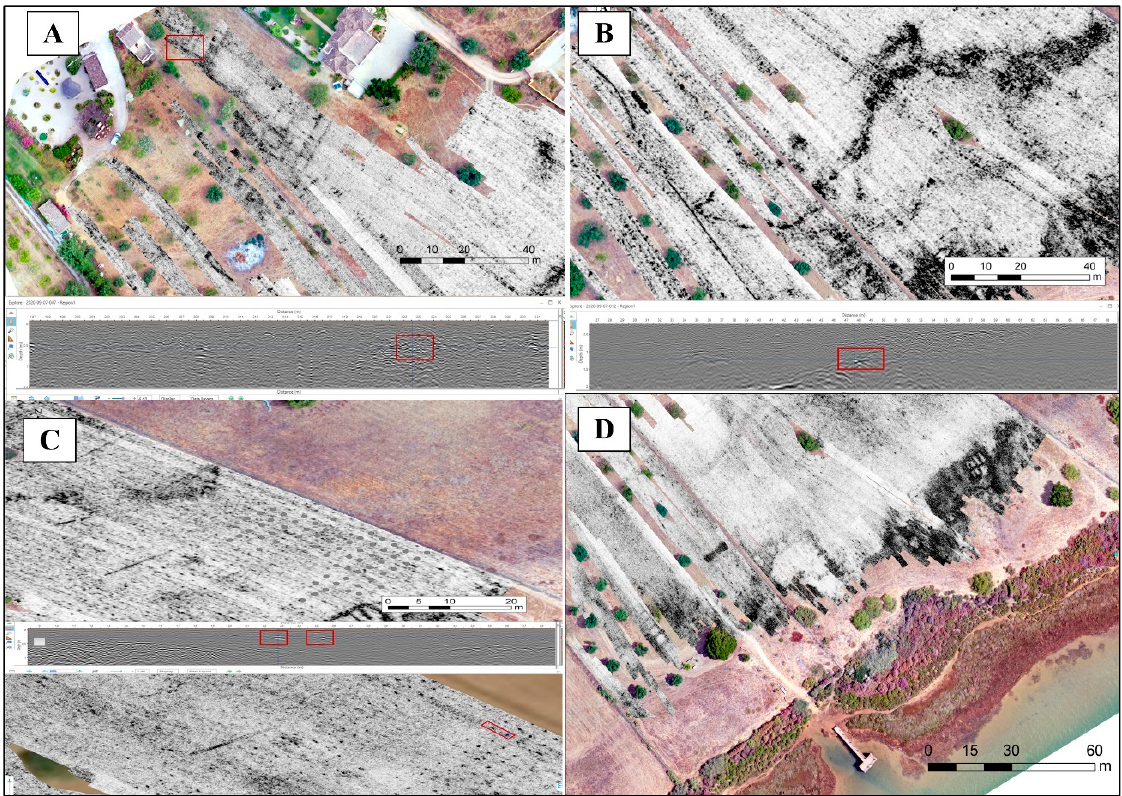
Figure 12. Main alterations to project 3 in GRED HD: ( A ) P1-1; ( B ) P1-2; ( C ) P1-3; ( D ) P1-4.